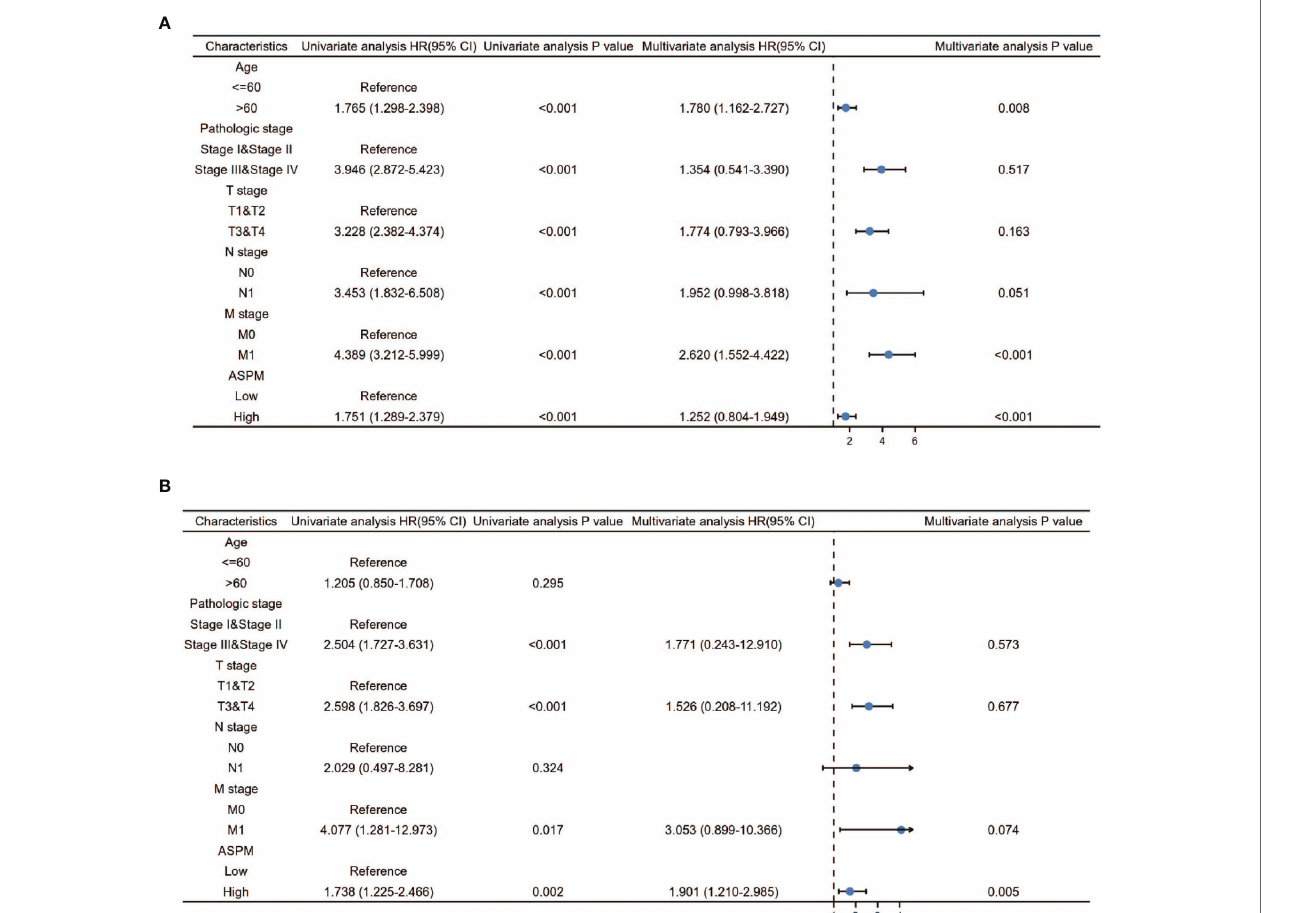
FIGURE 9 | Univariate and Multivariate Cox analysis of ASPM and pathological parameters in KIRC (A) and LIHC (B) . 611 KIRC patients and 424 LIHC patients were used for analysis. Patients were divided into different subgroups according to, age, clinical stage, clinical TNM stage, and ASPM expression. For each subgroup, the prognostic performance of ASPM on overall survival was evaluated by Cox regression, and the results are presented as hazard ratio (HR). The bar represents the 95% con fi dence interval of